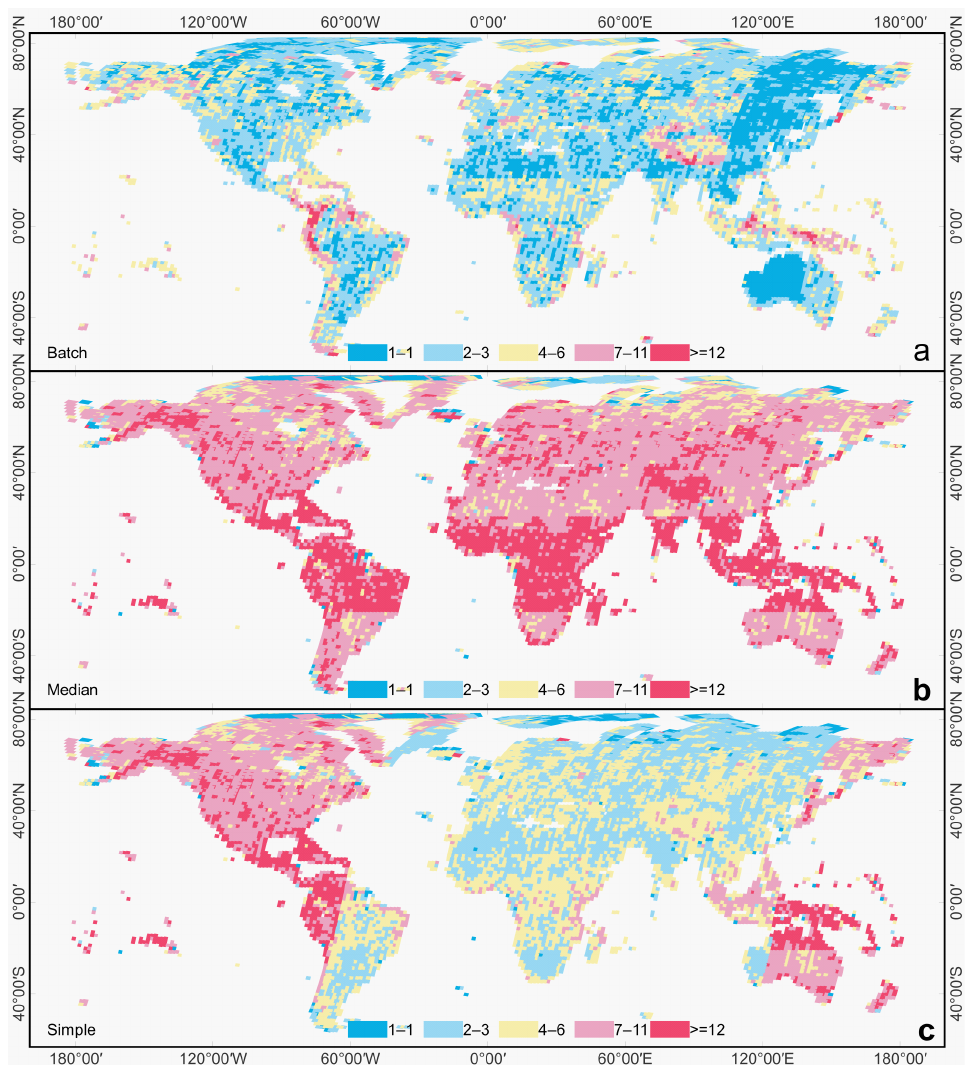
Figure 6. Spatial distribution of the required observation count for 99% integrity of the global composi- tion in 2019; ( a ) shows the algorithm used in this study; ( b , c ) show the median and simple algorithms.